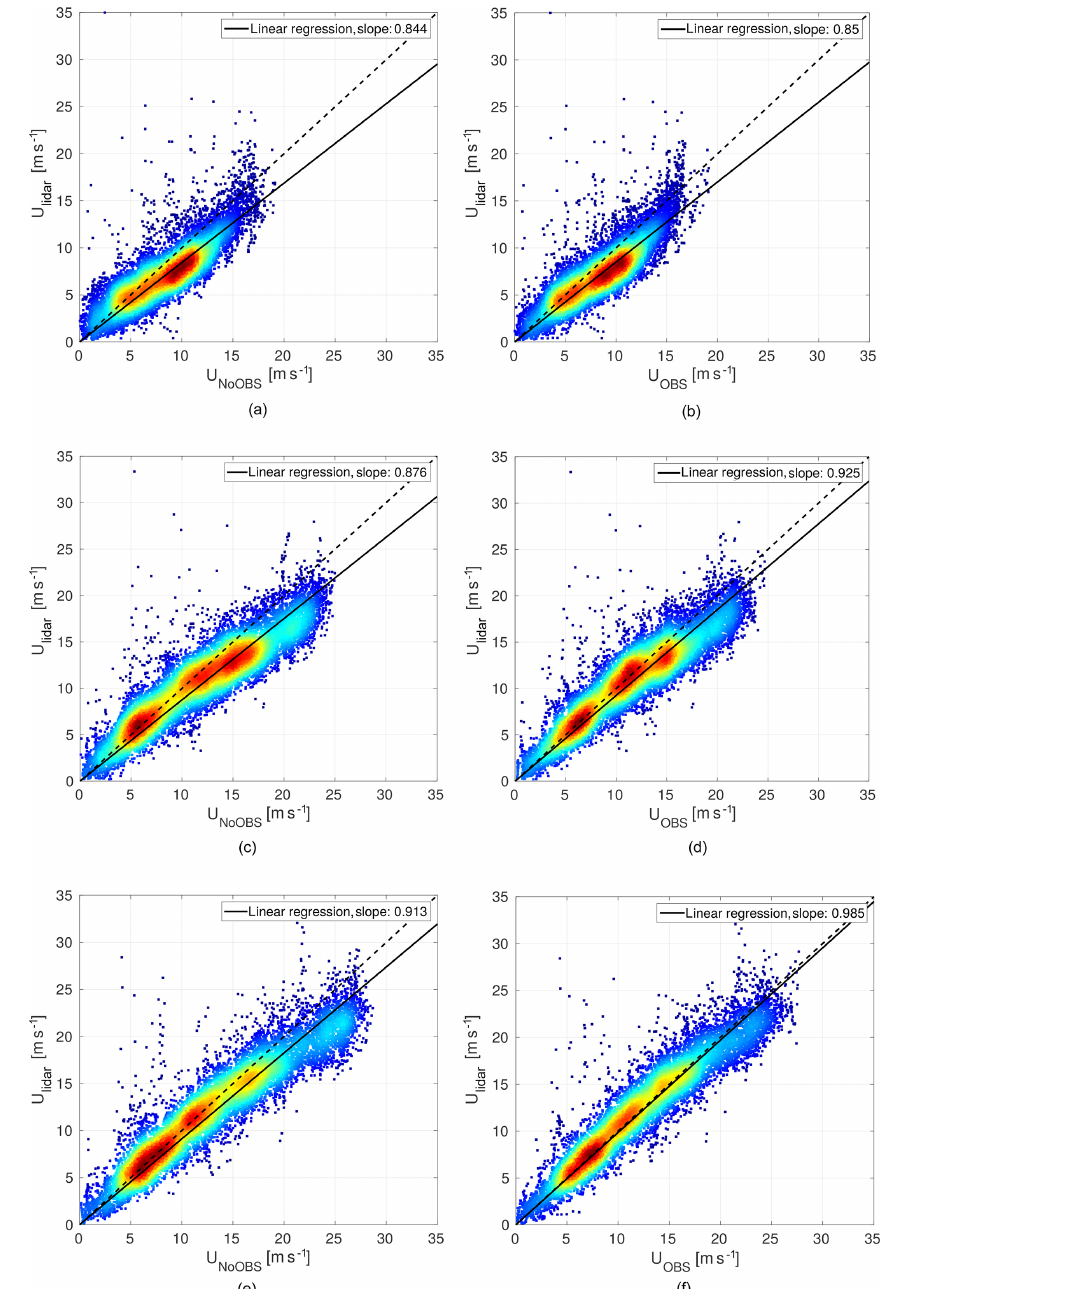
Figure 2. Linear regression of lidar-measured wind speeds against NoOBS-modeled (WRF “baseline run” without observation nudging) wind speeds (a, c, e) and OBS-modeled (“test run” with OBSGRID observation nudging) wind speeds (b, d, f) at ∼ 100m (a, b) , ∼ 300m (c, d) and ∼ 500m (e, f)